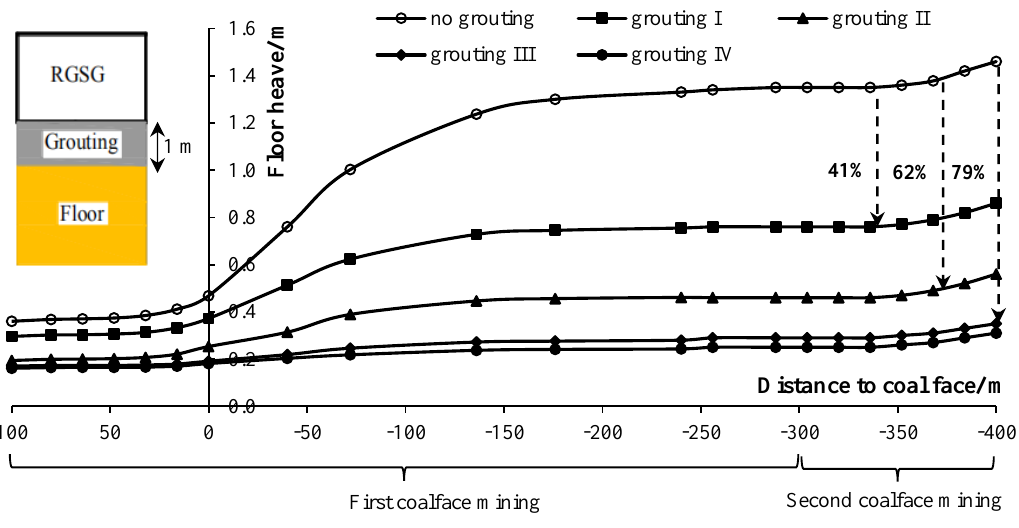
Figure 14. Floor heave of the RGSG after reinforcement with different grouting schemes.